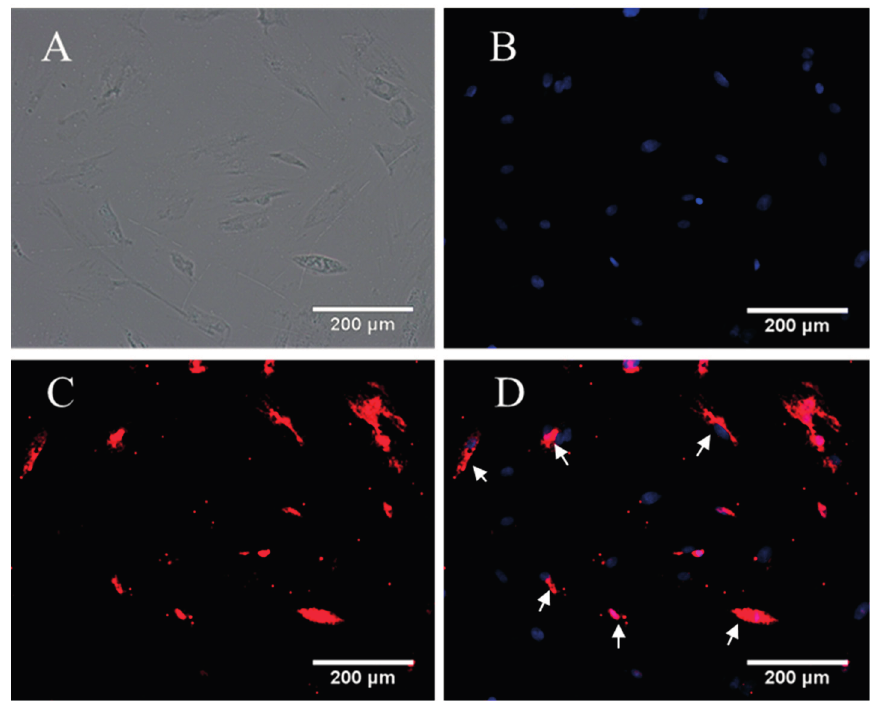
Figure 5. Immunofluorescence staining of OEC first cultured in DF-12 medium containing 10% FBS for 3 days and then cultured in DF-12 medium containing 10% RS and spinal cord explants for 4 days. Many cells were cultured; however, only a few OEC survived (white arrow). ( A ) OEC under an optical microscope; ( B ) OEC nuclei stained with DAPI; ( C ) OEC stained with Cy3; and ( D ) the merged B and C. Scale bar is 200 μ